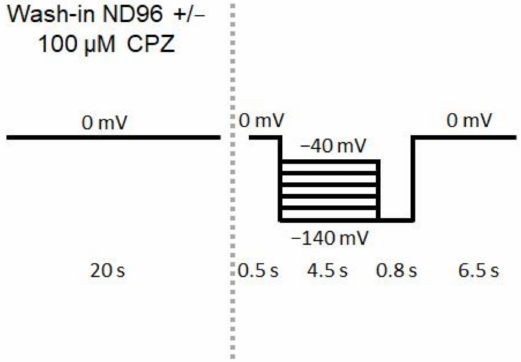
Figure 2. The pulse protocol for the TEVC